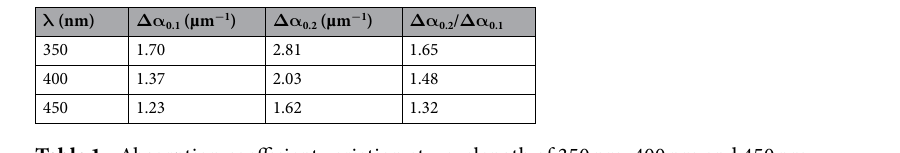
Table 1. Absorption coefficient variation at wavelength of 350 nm, 400 nm and 450